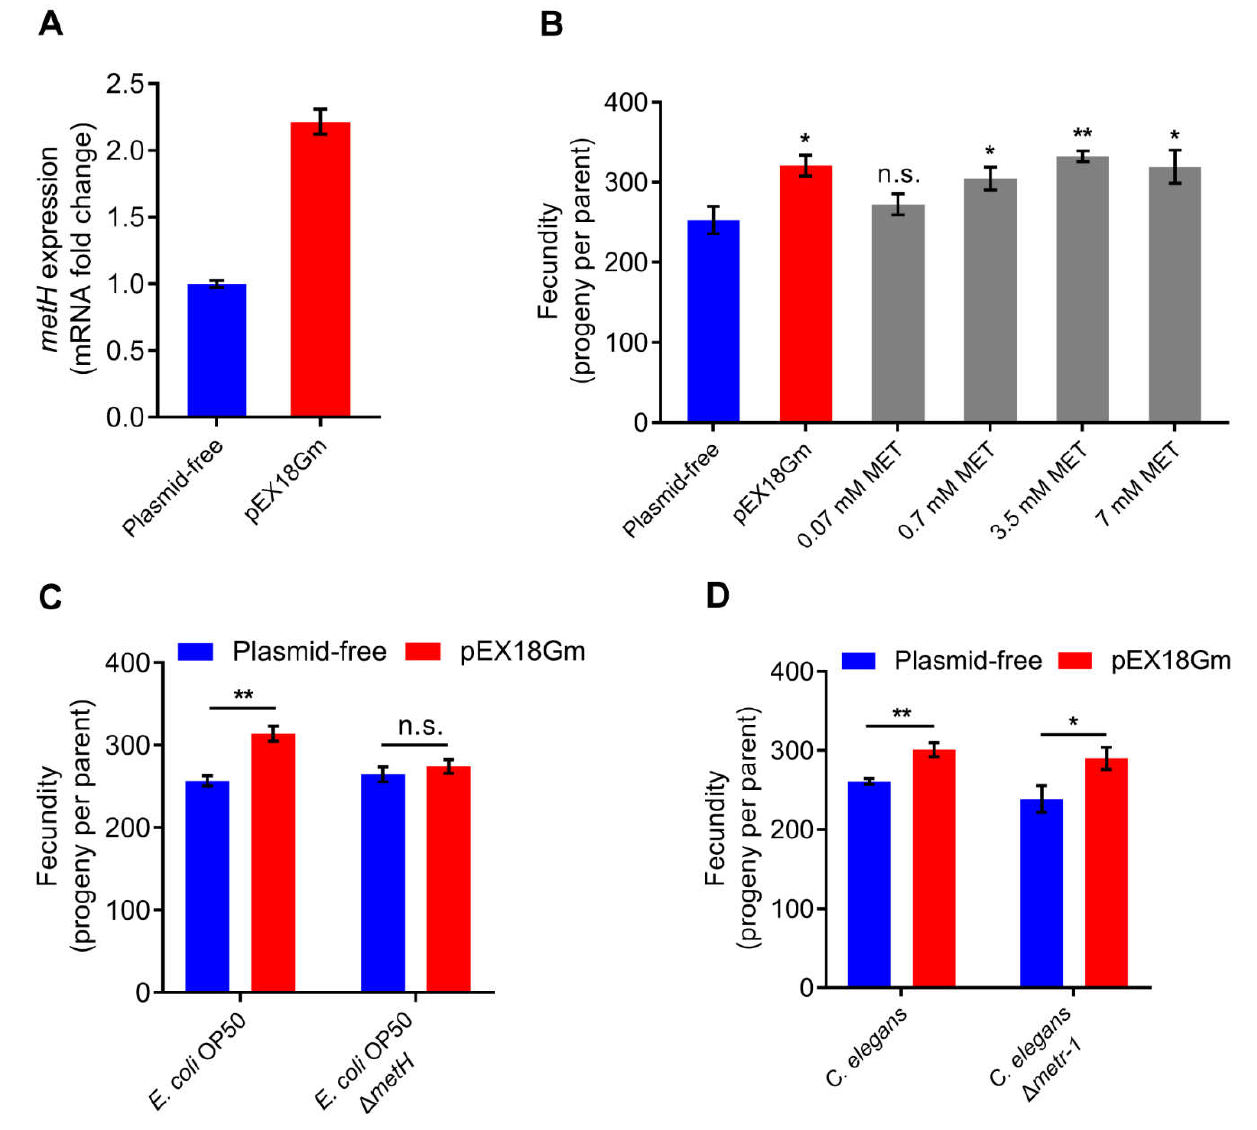
Figure 3. The bacterial methionine synthase metH is necessary for pEX18Gm-induced increase in C. elegans fecundity. ( A ) mRNA expression of gene metH in plasmid-free E. coli OP50 and E. coli OP50 harboring pEX18Gm. qRT-PCR data, normalized to the metH levels in E. coli OP50, the house-keeping gene used gapA . ( B ) Fecundity of C. elegans in E. coli OP50 diet on NGM plates supplemented with different concentrations of methionine (MET). ( C ) Effect of pEX18Gm plasmid on the fecundity of C. elegans grown on E. coli OP50 and mutants E. coli OP50 ∆ metH . metH indicates E. coli methionine synthase gene. ( D ) Effect of plasmid pEX18Gm on the fecundity of C. elegans ∆ metr-1 mutant in E. coli OP50 diets. metr-1 indicates C. elegans methionine synthase gene. Error bars indicate ± SEM. * p < 0.05; ** p < 0.01 by Student’s t test ( A , C , D ) and Tukey’s multiple comparison test ( B ); n.s. indicates not significant.